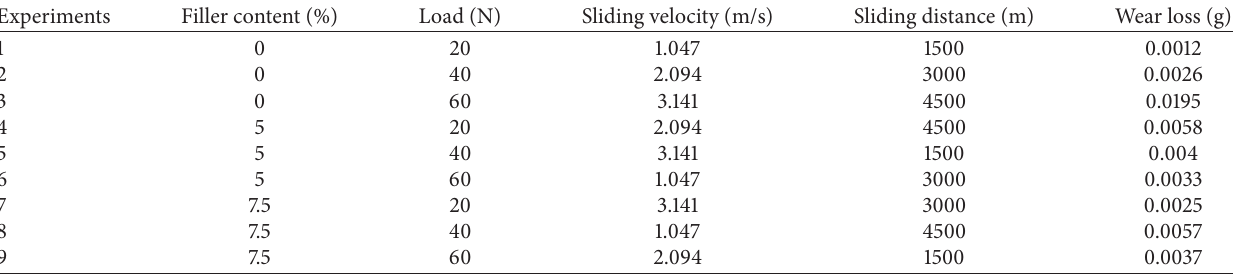
array with output result. 9